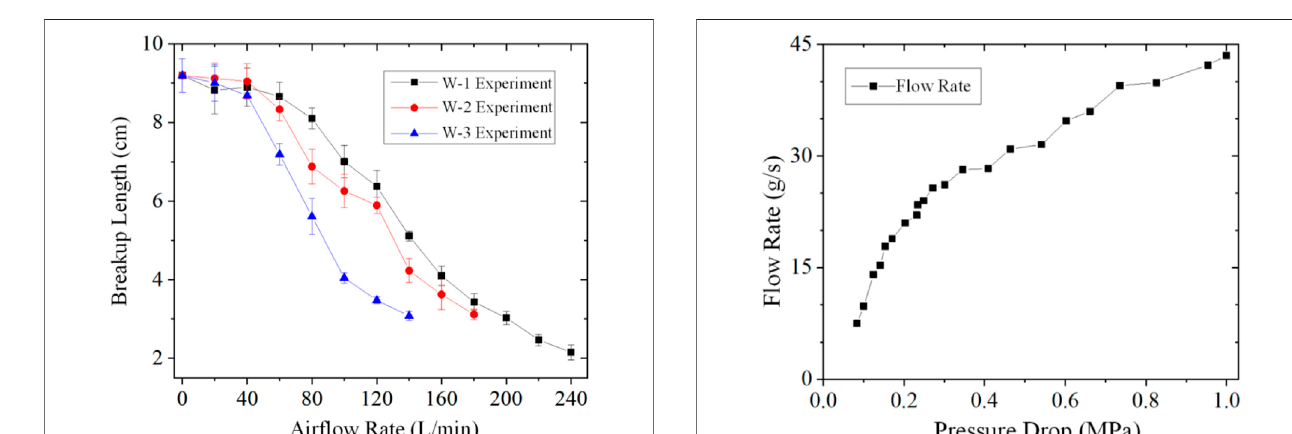
Frontiers in Energy Research |